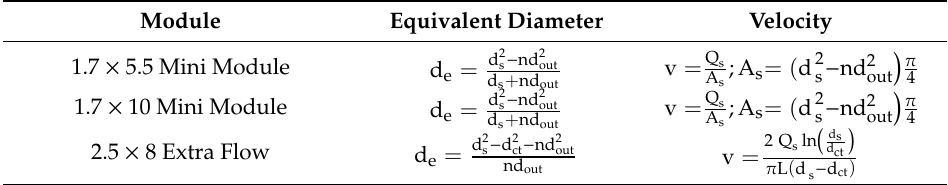
Table 2. Equivalent diameter and velocity equations of the shell side for each HFMC module [11]. Module Equivalent